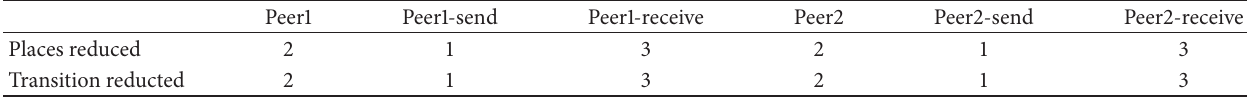
Table 1: The reduction results of every page.